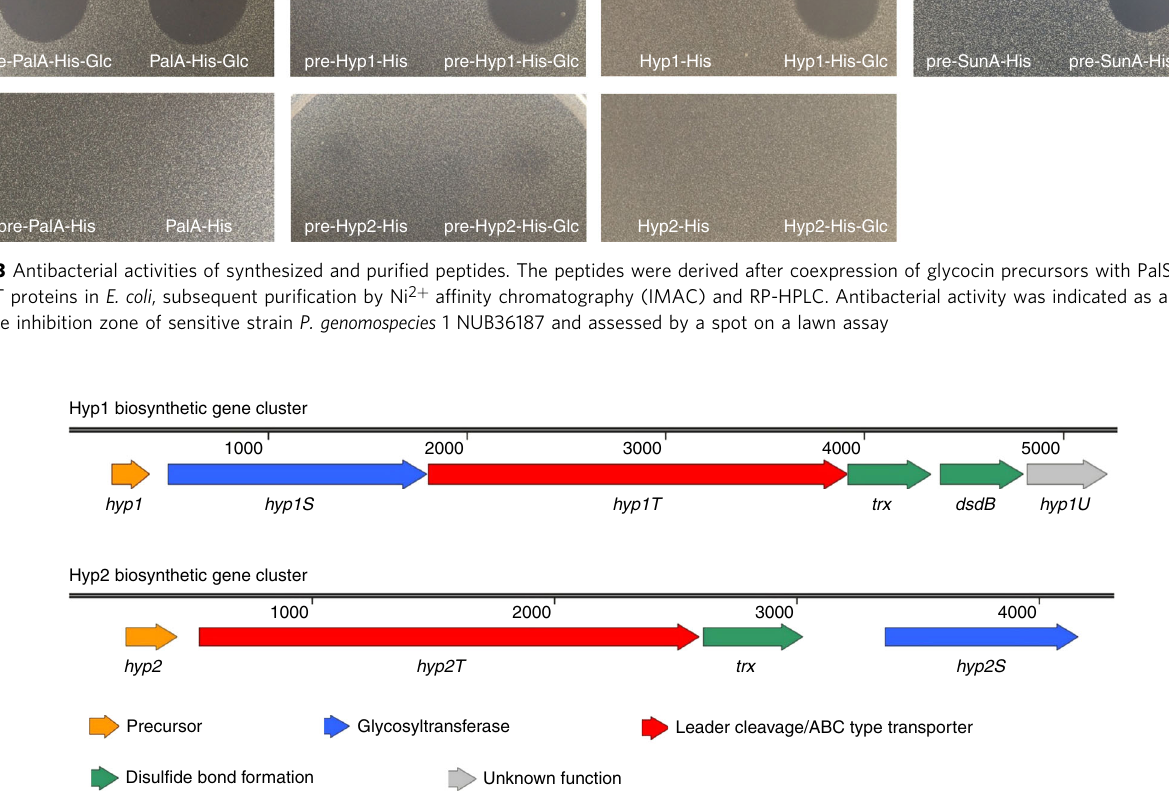
Fig. 4 The predicted biosynthetic gene clusters of glycocins Hyp1 and Hyp2. Hyp1 biosynthetic gene cluster encoded in the genome of B. megaterium BHG1.1 is 5013 bp in length and encodes for proteins: Hyp1, Hyp1S, Hyp1T, Trx, DsbB, and Hyp1U. The Hyp2 biosynthetic gene cluster encoded in the genome of Bacillus sp. JCM19047 is 3932 bp in length and encodes for proteins: Hyp2, Hyp2T, Trx, and